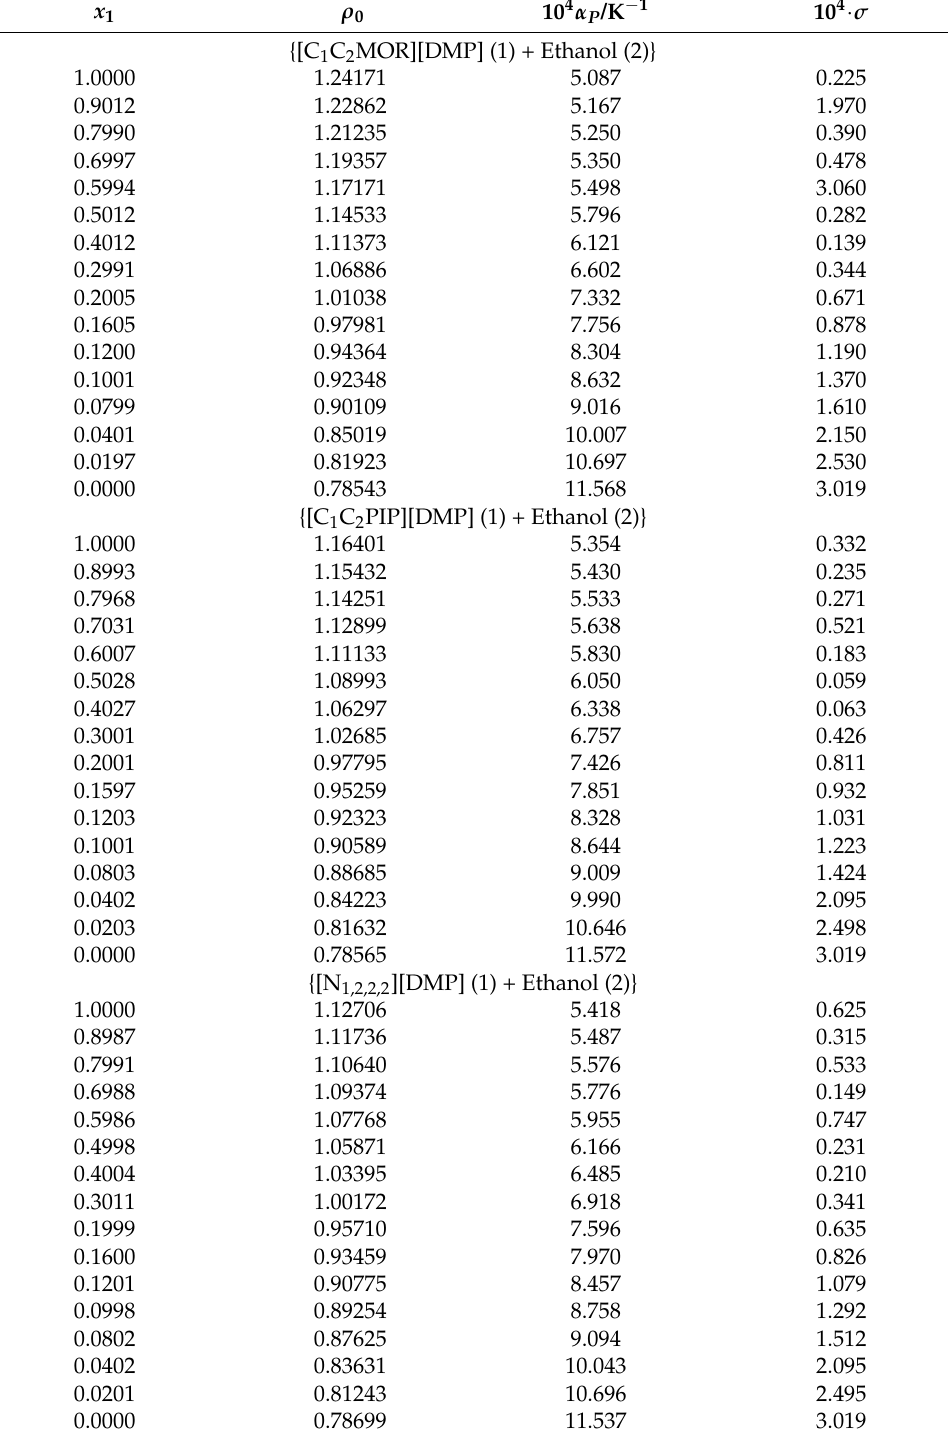
Table 9. The parameters of Equations (10) and (11) for correlation temperature dependence of the density of {IL (1) + Ethanol (2)} binary systems a